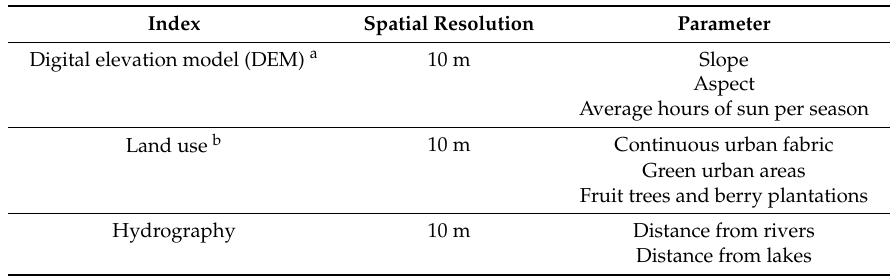
Table 1. List of the environmental GIS layers included in the analysis.